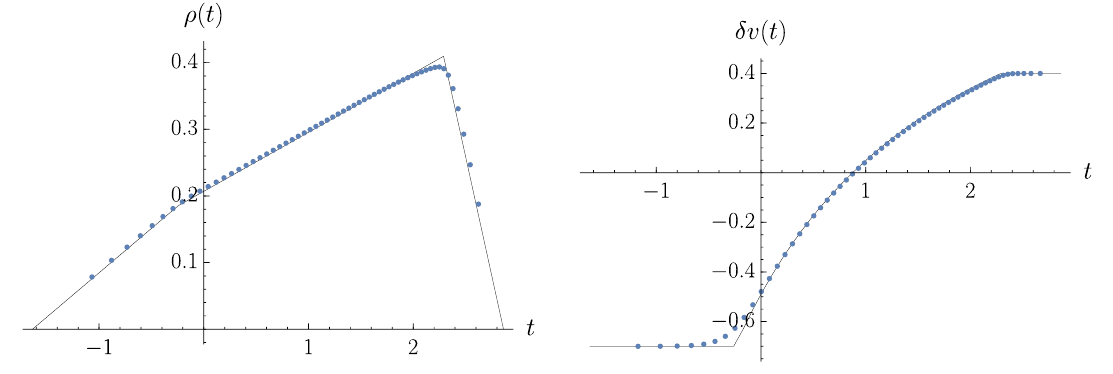
Figure 2 . The eigenvalue density (cid:26) ( t ) and the function (cid:14)v ( t ) for (cid:1) a = f 0 : 4 ; 0 : 5 ; 0 : 7 ; 2 (cid:25) (cid:0) 1 : 6 g and N = 60, compared with the leading order